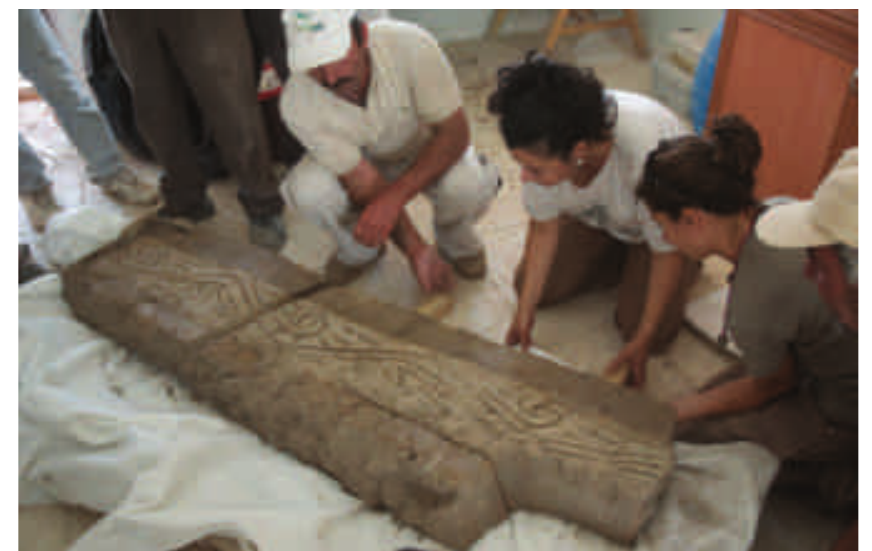
Figure 6 The frieze immediately after lifting